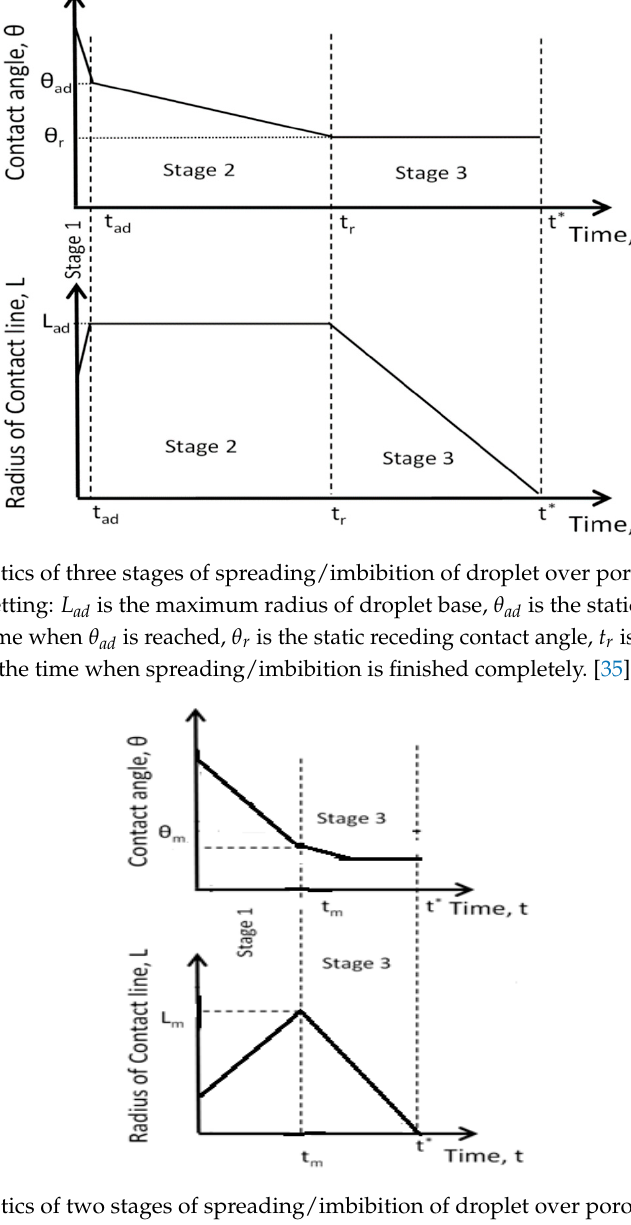
Figure 2. Schematics of two stages of spreading/imbibition of droplet over porous substrates in the case of complete wetting: L m is the maximum radius of droplet base, t m is the time when L m is reached, θ m is the contact angle at the moment t m , t* is the time when complete imbibition is finished and θ f is the final contact angle at t* . The contact angle θ f is completely determined by hydrodynamic reasons and has nothing to do with the static receding contact angle, because there is no contact angle hysteresis in the case of complete wetting [35].